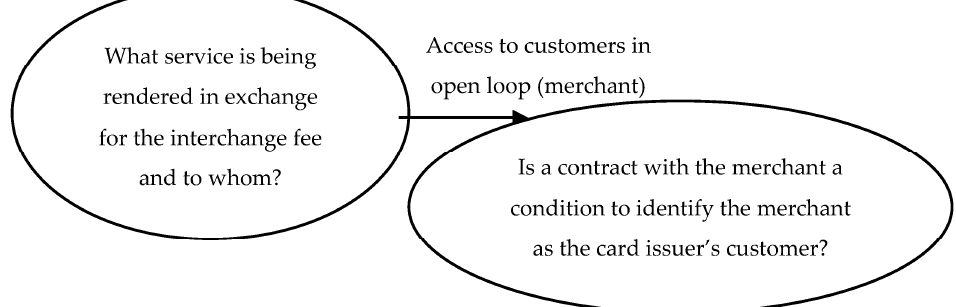
Figure 6. Impact of a contract with the merchant in an open loop structure on identifying the cus- tomer in relation to the card